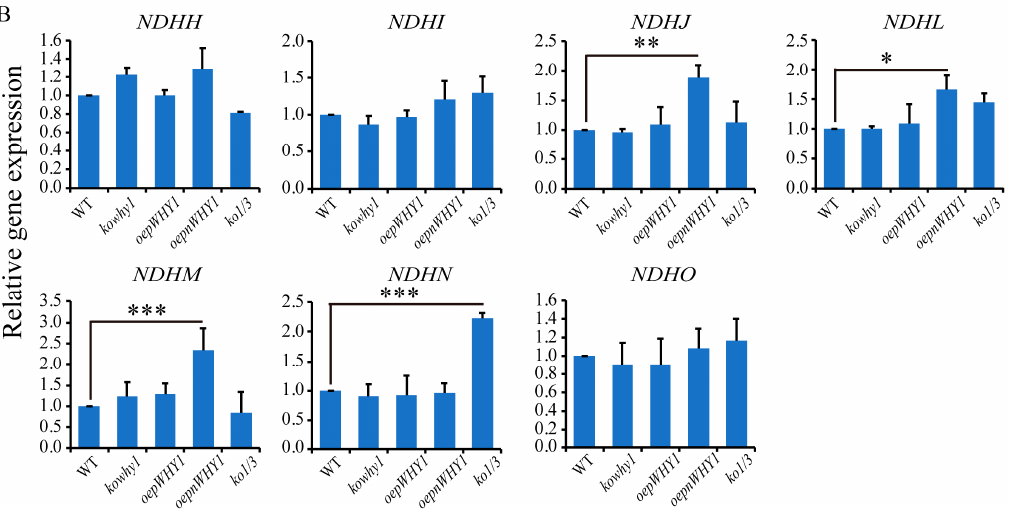
Figure 4. Expression of NDH-encoded genes in different WHY1 mutants and wild-type plants. ( A ) Expression analysis of NDH membrane complex encoded genes in WHY1 mutants and wild-type plants by qPCR; ( B ) Expression analysis of NDH subcomplex-A encoded genes in WHY1 mutants and wild-type plants. The transcript level in each case was normalized to that of GAPC2 as a reference gene, and the expression level of WT was set as 1. Three biological replications were used in the analysis. Asterisk indicate significant differences in gene expression compared to WT (Tukey–Kramer method, * p < 0.05, ** p < 0.01, *** p < 0.001).